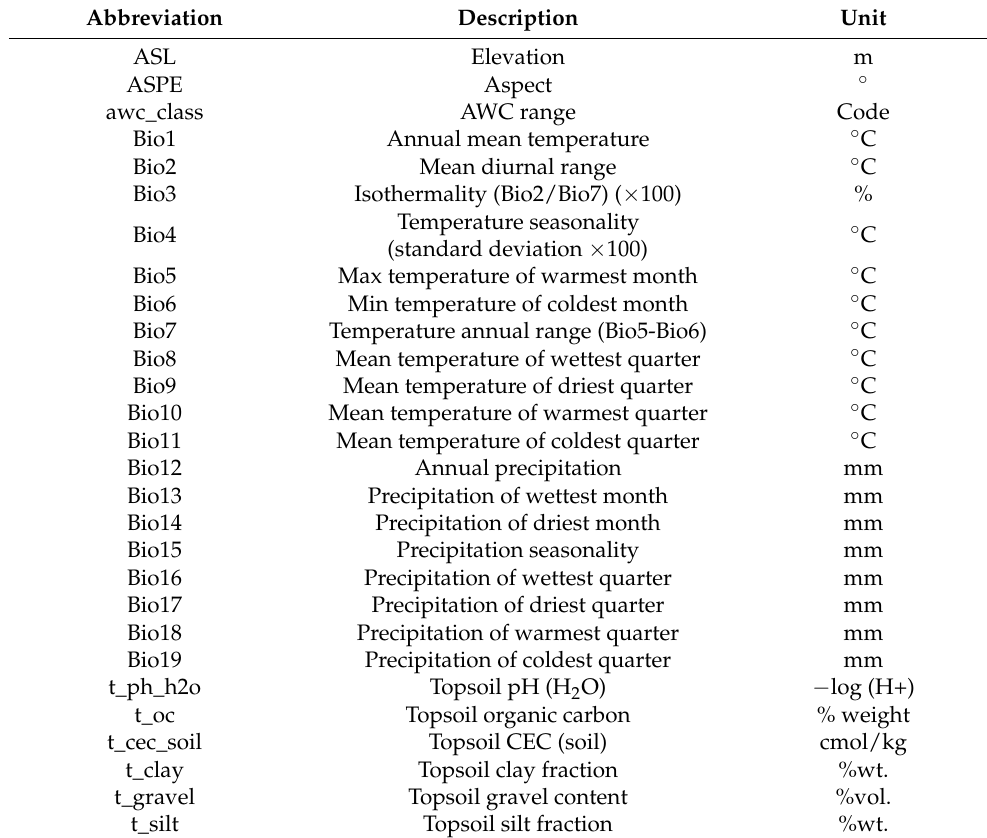
Table 1. Environmental factors used in this study. The highlighted cells are the environmental factors used in the